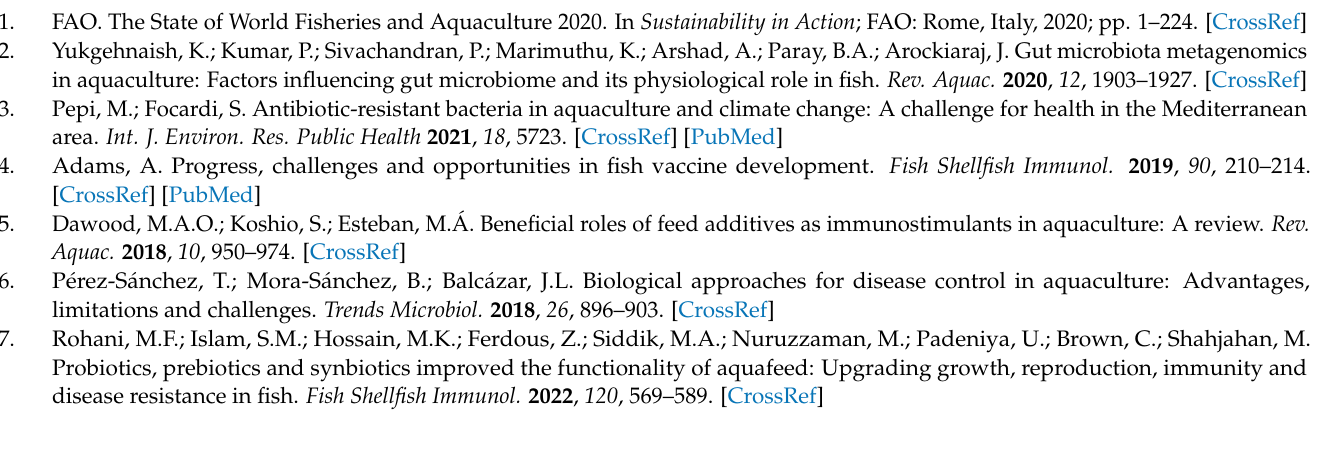
ple for multiplexing and Illumina sequencing. Figure S1: Bar plot summarizing the relative bacterial abundance at the class level in different gut regions (foregut and hindgut) and treatments. Control refers to gilthead seabream juveniles fed with basal diet while Allium -derived PTSO refers to exper- imental gilthead seabream juveniles fed with basal diet supplemented with Allium -derived PTSO. Figure S2: principal coordinate analysis based on (A) weighted and (B) unweighted UniFrac distance matrixes exploring differences in bacterial community between both gut regions (blue: foregut, red: hindgut). Percentages show the proportion of variance explained by each axis. Figure S3: principal coordinate analysis based on weighted and unweighted UniFrac distance matrices exploring differ- ences in bacterial gut community among different tanks of control and Allium -derived PTSO (red: control, tank 1, blue: control, tank 2, orange: control, tank 3, green: Allium -derived PTSO, tank 1, purple: Allium -derived PTSO, tank 2, yellow: Allium -derived PTSO, tank 3). Percentages show the proportion of variance explained by each